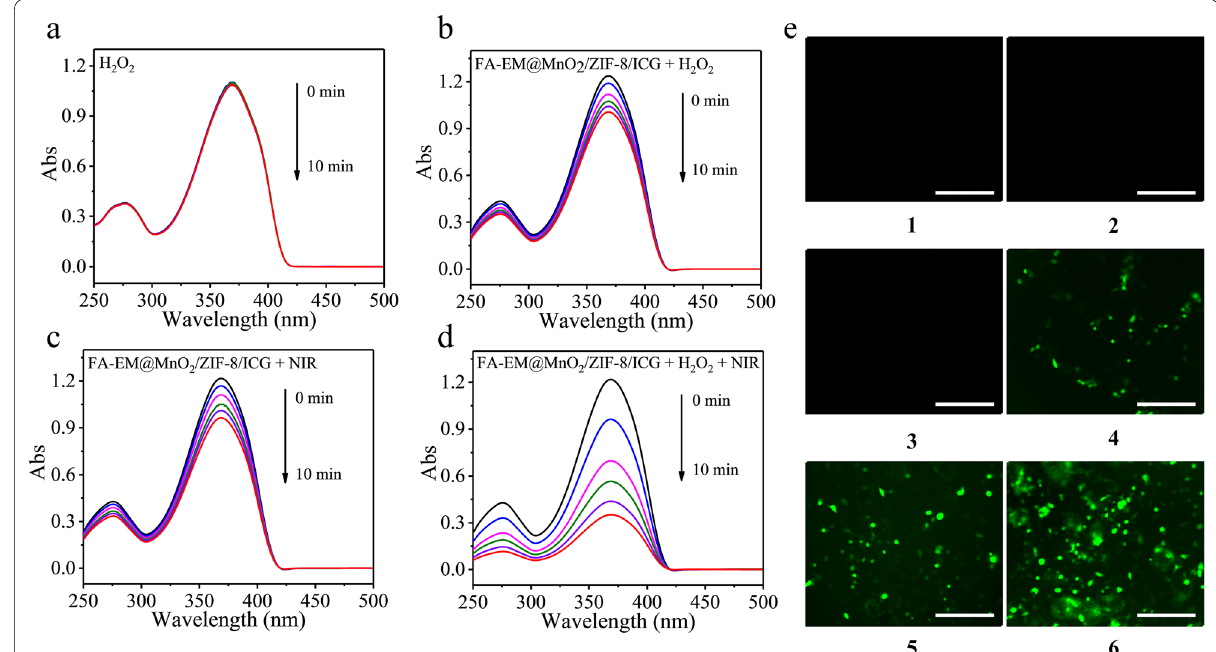
Fig. 5 UV–vis absorption of DPBF in H 2 O 2 ( a ), FA-EM@MnO 2 /ZIF-8/ICG ICG H 2 O 2 NIR ( d ) at different time points. e CLSM images of DCF in 4T1 cells without any treatments (1), and treated with NIR irradiation only (2), + +